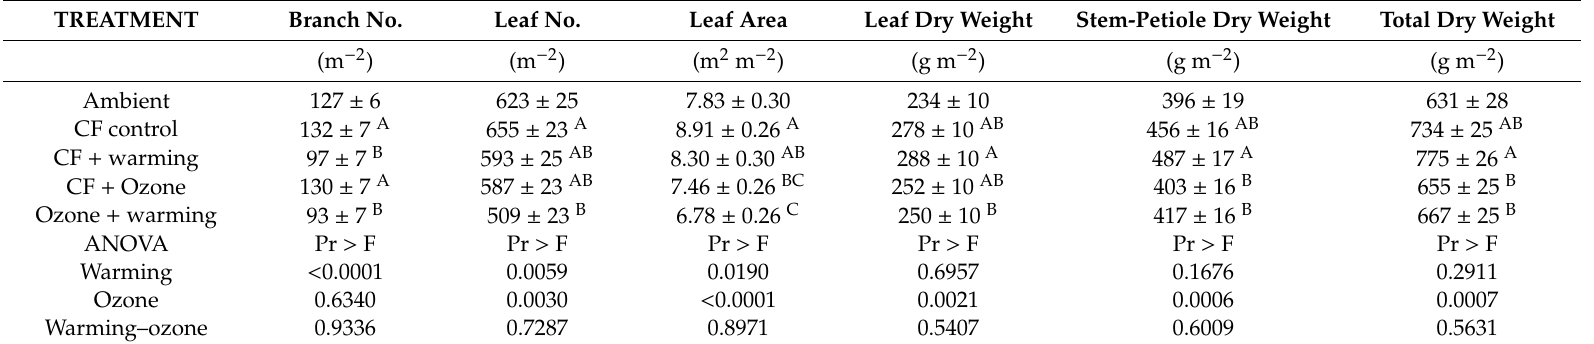
Table 2. Mid-season soybean biomass at the flowering